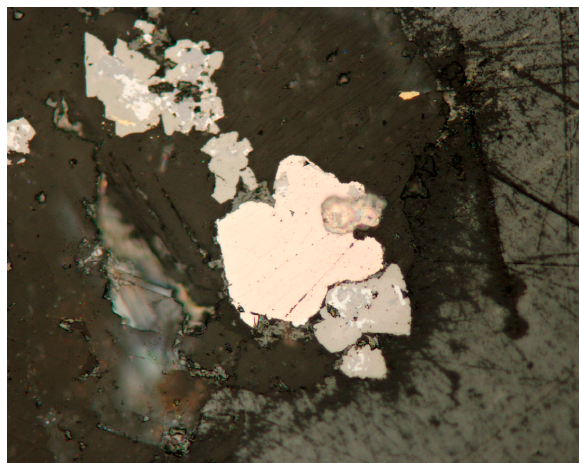
Figure 28. Pinkish subhedral dzharkenite grain in association with dark grey tetrahedrite enclosed light grey tiemannite inclusions. Reflected light, one polarizer. FOV 210 μ m. P ř íbram, a dump of shaft 16. Photo by P. Škácha.